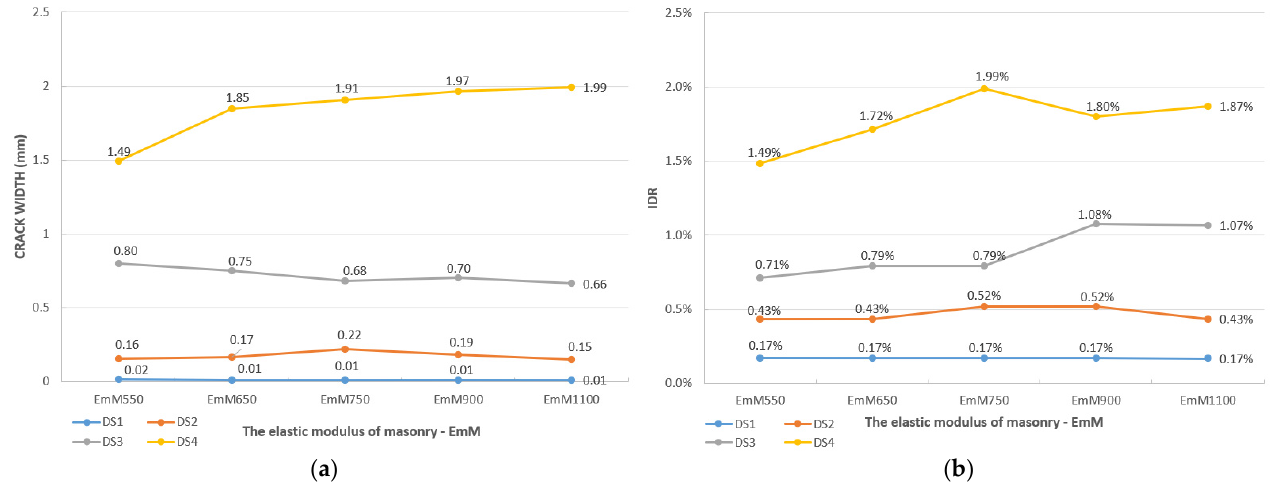
Figure 16. Correlation of damage states (DS) and elasticity modulus of masonry (EmM) associated with: ( a ) crack width (mm); ( b ) IDR (%).